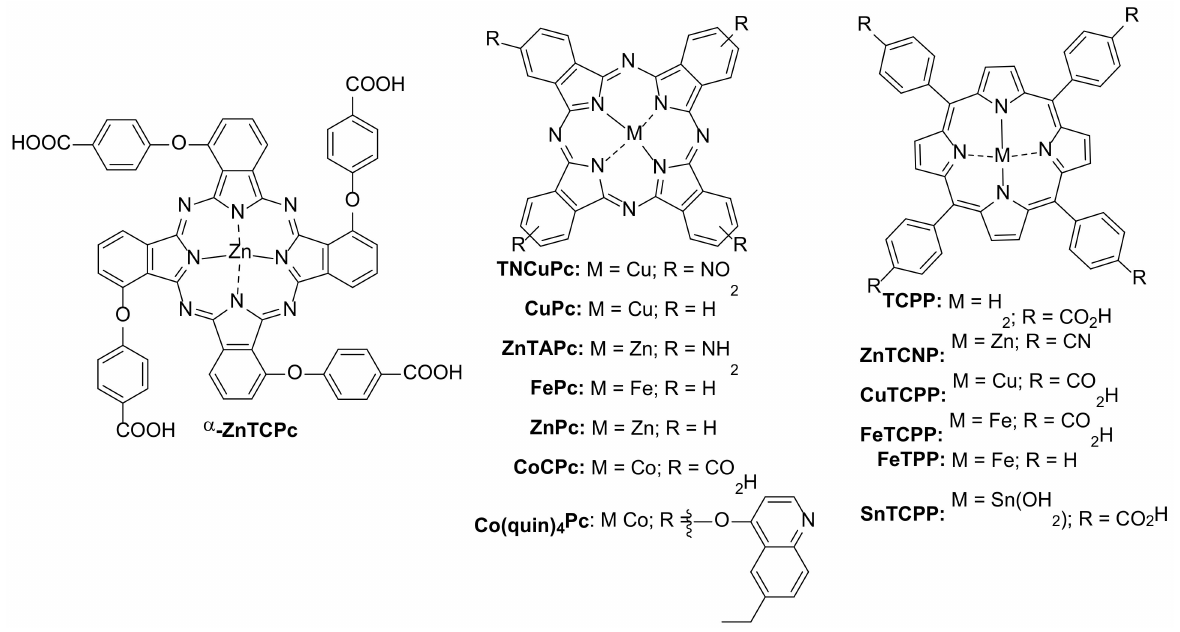
Figure 2. Structures of tetrapyrrolic macrocycles (TPM) used as catalysts for photodegradation of